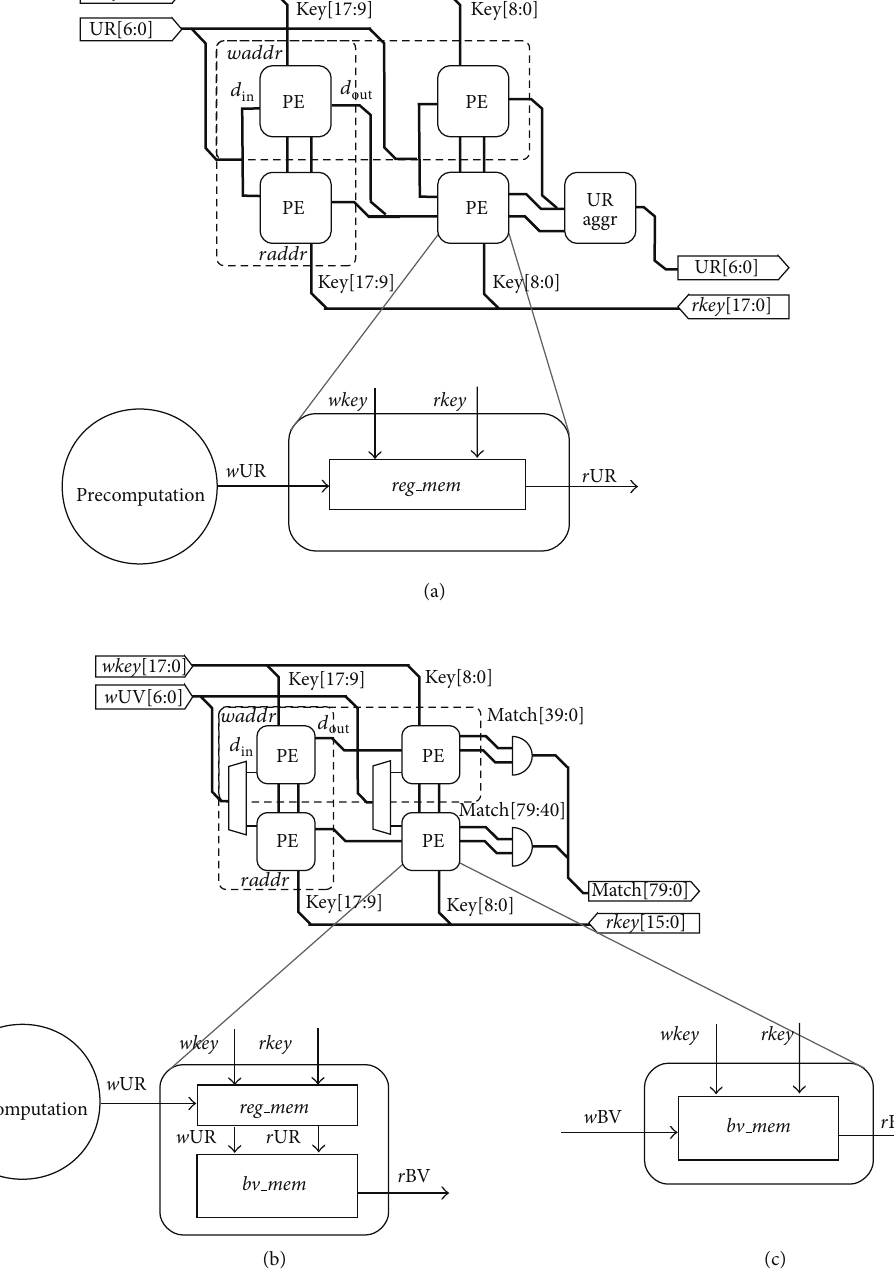
Figure 12: Stitching architecture: (a) lookup for UR-based aggregation and (b) and (c) lookup for UV-based aggregation.